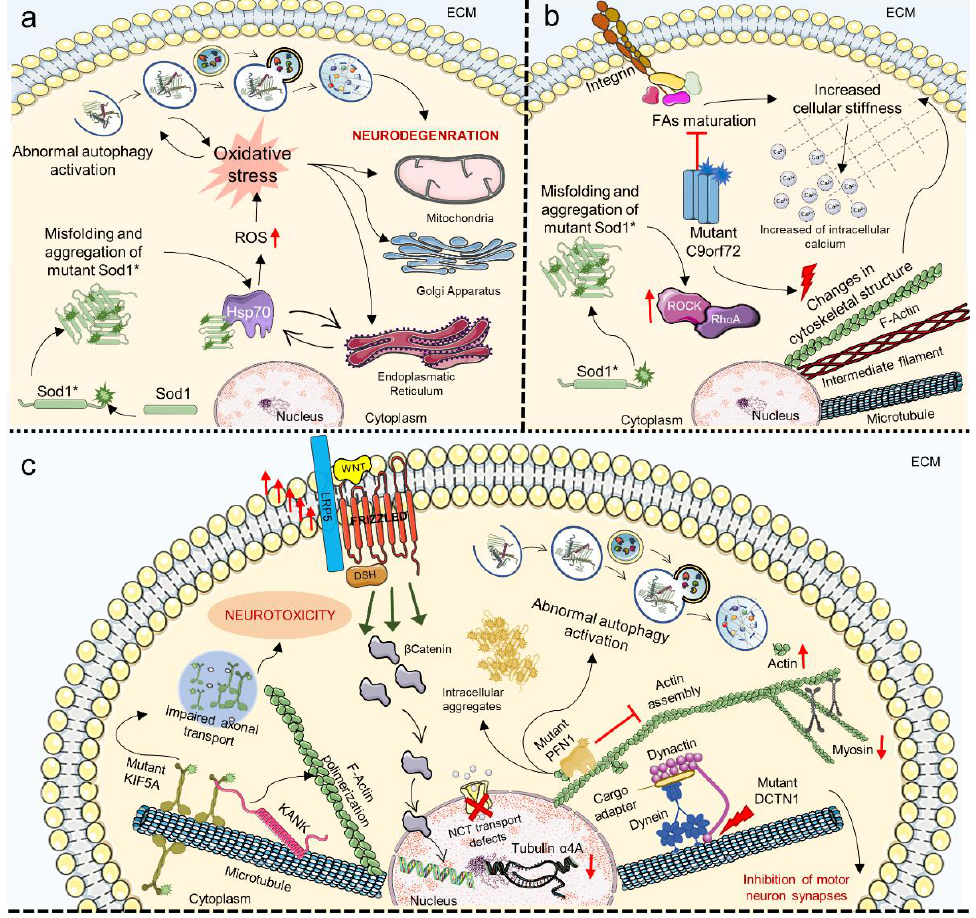
Figure 5. Biochemical pathways of cellular mechanosensing and mechanotransduction involved in Amyotrophic Lateral Sclerosis (ALS) pathological mechanisms: ( a ) Pathogenic molecular mechanism of mutant (*) Superoxide Dismutase 1 (Sod1*) and effects on cellular homeostasis; ( b ) Effect of Sod1* and mutant C9orf72 dipeptides aggregation on cellular adhesion, RhoA/ROCK signaling and cytoskeletal structure; ( c ) Biochemical mechanotransduction pathways affecting cytoskeletal and nuclear homeostasis evidenced in ALS (see main text for details). Red arrows up ↑ or down ↓ indicate up or downregulation. C9Oorf72, Chromosome 9 open reading frame 72; Ca 2+ , Calcium ion; DCTN1, Dynactin Subunit 1; DSH, Dishevelled; FAs, focal adhesions; HSP70, Heat shock protein 70; KANK, KN motif and ankyrin repeat domain-containing protein 1; KIF5A, cytoskeleton-related proteins such as Kinesin; LRP5, LDL Receptor Related Protein; NCT, nucleocytoplasmic; PFN1, Profilin 1; SOD1*, mutant Superoxide Dismutase 1; WNT, Wingless/Integrated.